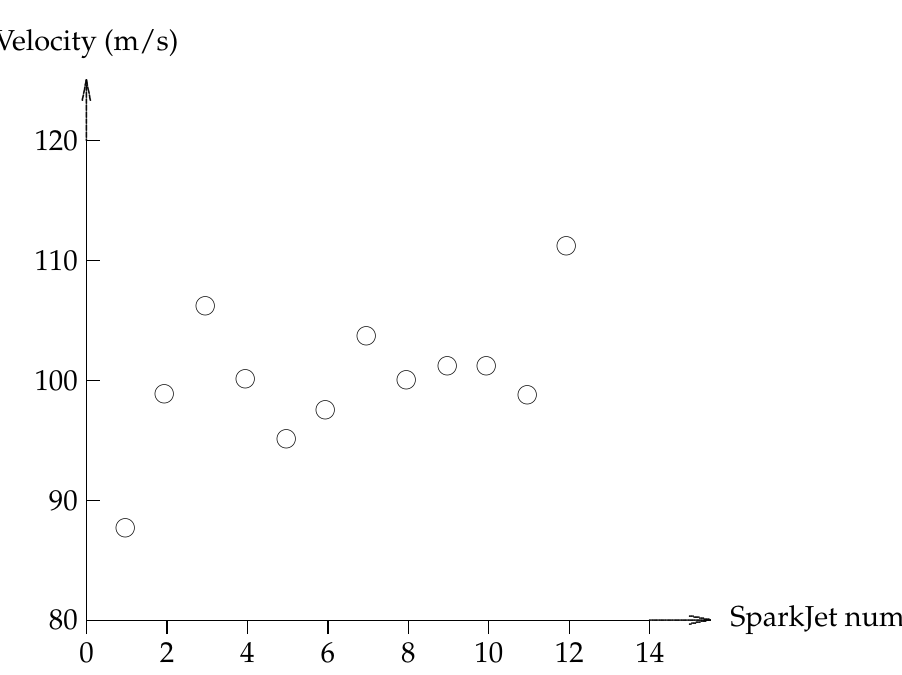
Figure 16. Jet front velocity of each SparkJet in the 12-SparkJet array. Figure 14. Jet front velocity of each SparkJet in the 12-SparkJet array. Zhang et al. [55] performed an experimental examination of the 10-SparkJet array on the interaction of the supersonic turbulent boundary layer with a 20 ◦ compression corner at Mach 2. The SparkJet array is placed in the streamwise direction and connected to a single power supply. The experimental configuration is shown in Figure 15. As seen in Figures 16 and 17, the 10-SparkJet array has a significant effect on the flowfield structure. The effective controlling time for the SparkJet array was about two times the jet ejection time for a single actuator.